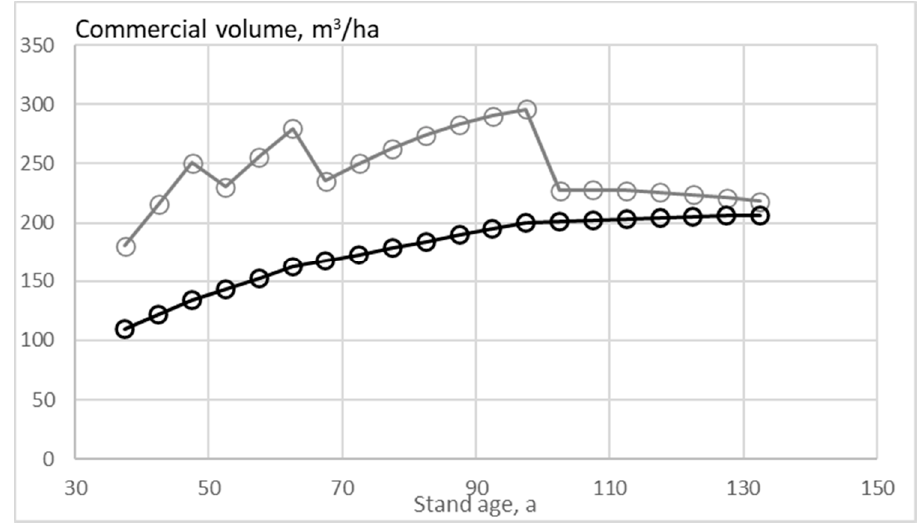
Figure 10. Commercial volume per hectare (thin drawing) and expected values accumulated over stand age (thick drawing), with thinnings from below.